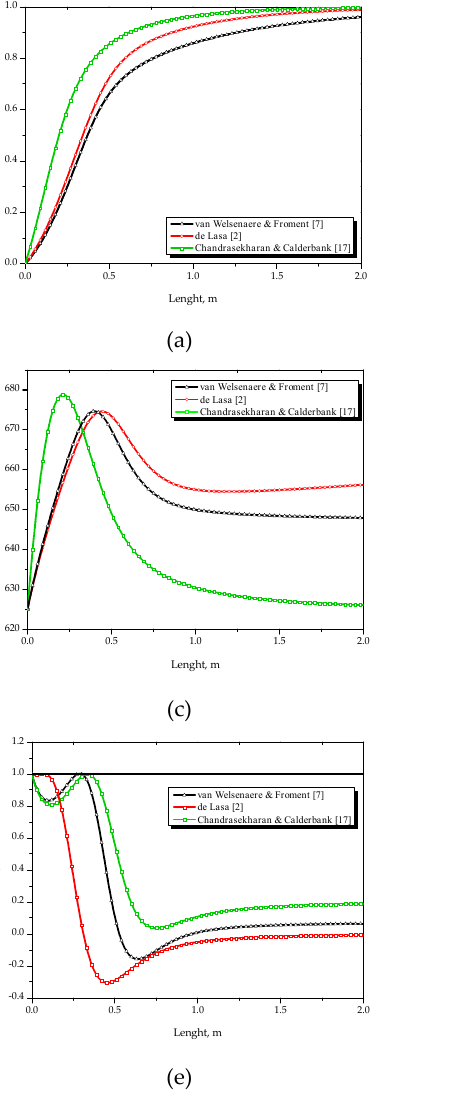
Figure 3. Effect of cooling flow pattern and kinetic model on: conversion, reaction temperature and temperature sensitivity index profiles. Co-current flow: ( a , c , e ); and countercurrent flow ( b , d , f ). Tc o = T o = 625 K, other simulation conditions from Table 2.